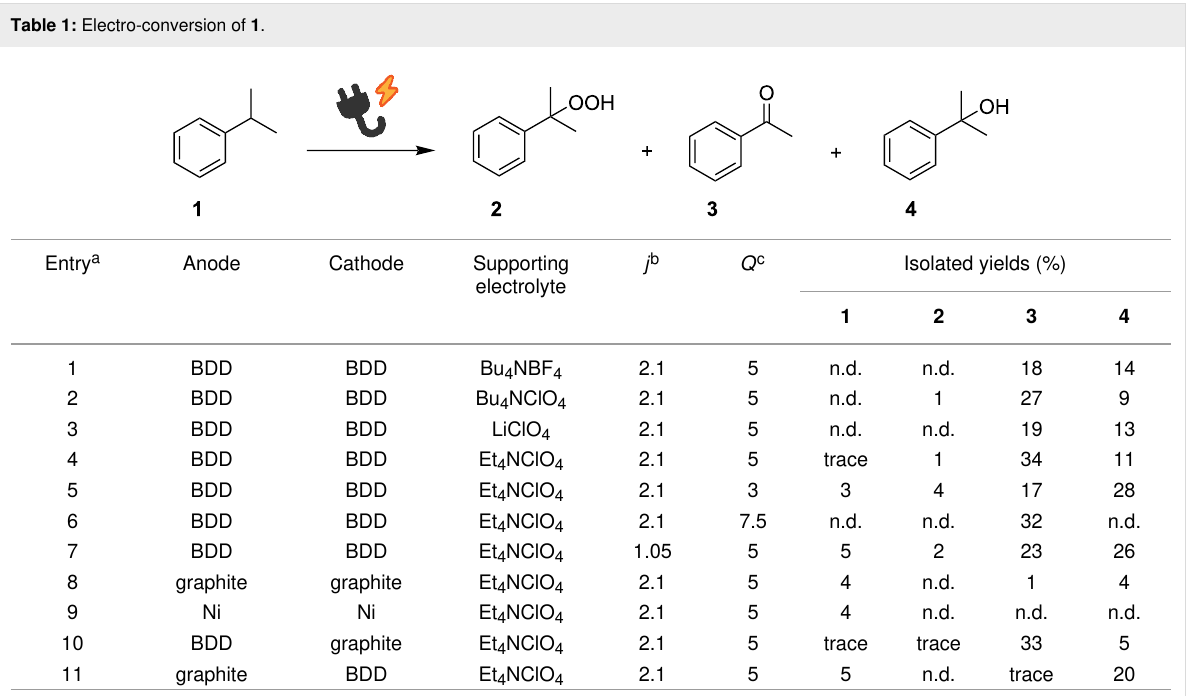
Table 1: Electro-conversion of 1 .